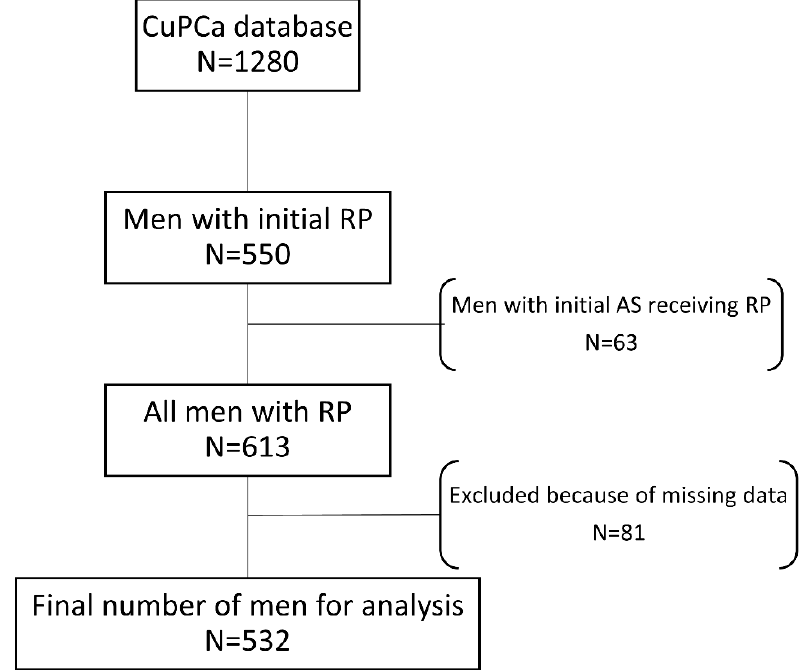
Figure 1. Inclusion overview of men analyzed from the Copenhagen uPAR prostate cancer (CuPCa) database. All men with radical prostatectomy (RP) as initial treatment were included. Men who got active surveillance (AS) before getting RP are also included.